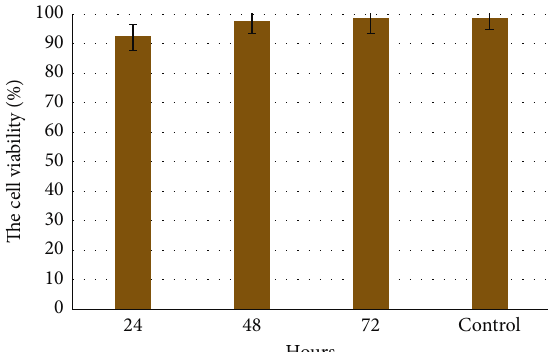
Figure 1: The cell viability study of the collagen/nanoclay/tadalafil hydrogel on HEK 293 cells for 24, 48, and 72h three independent tests was conducted ( p < 0 . 05 ) . Table 2: The antibacterial activity of collagen/nanoclay/tadalafil hydrogel against E . coli and S . aureus . Samples